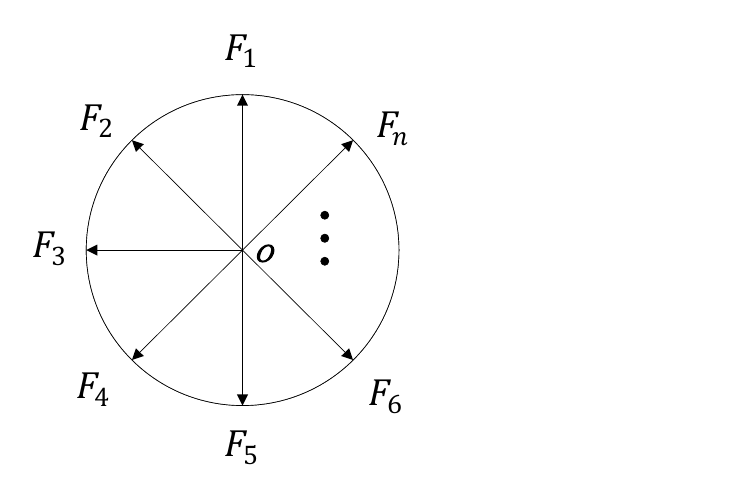
Figure 1. Schematic of 𝑛 vectors with the same angle.